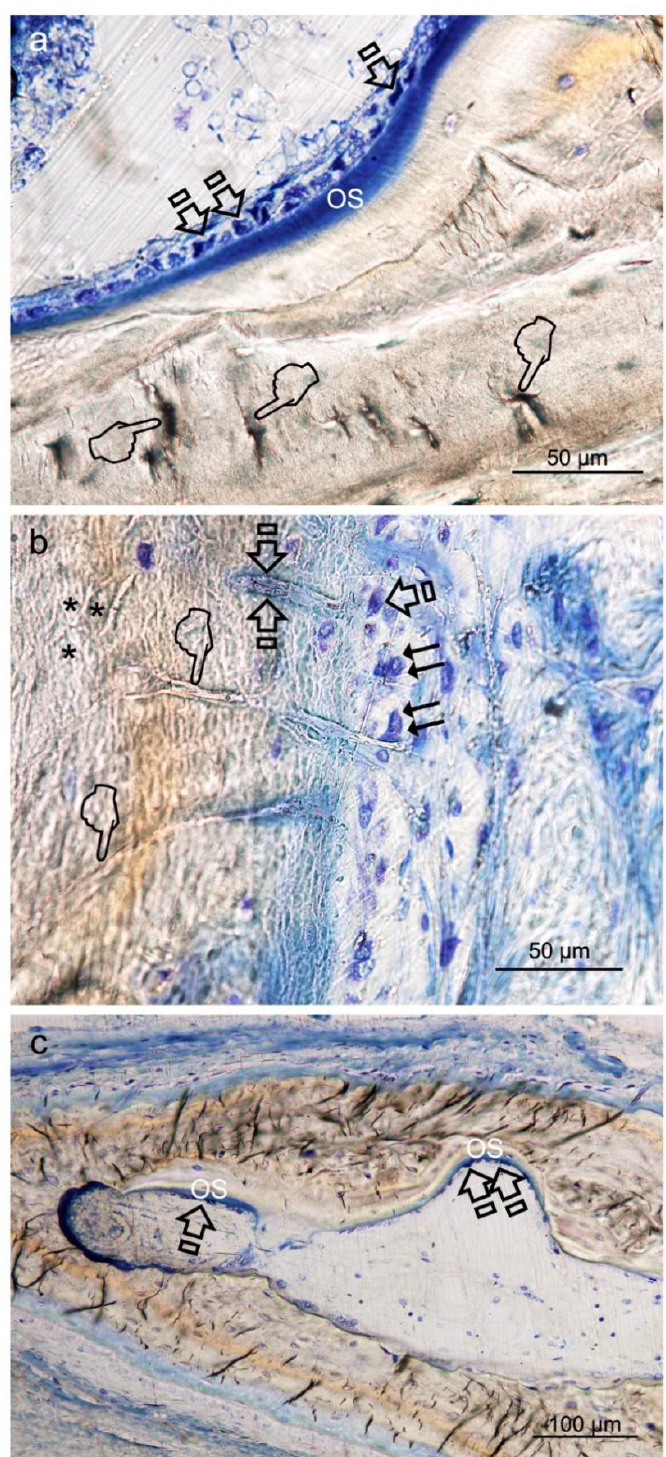
Figure 4. Bone histology images obtained after using Zn-HOOC-Si ( a ), Dox-HOOC-Si ( b ) loaded membranes, and control (no membrane) ( c ), by coloration with toluidine blue to visualize mineralized bone, at 6 weeks of healing time. Single arrows point the presence of aligned osteoblasts, with typical cuboid shape (Figure 4a). Polarized osteoblast (Figure 4a,b) show part of the cell membrane in direct contact with the bone surface, unveiling many cytoplasmic processes, that achieve the newly deposited osteoid ( OS ). Double arrows are indicative of osteoclasts; pointers mean canaliculi and faced arrows, an osteocyte. Asterisks are located at zones of gap junctions (Figure 4b).